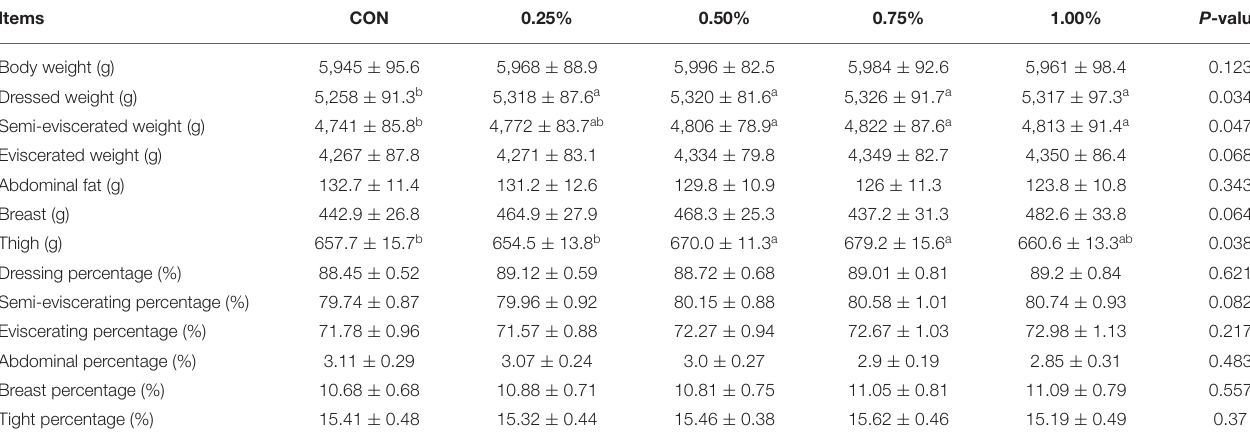
TABLE 3 | Effects of honeycomb flavonoids supplement on carcass performances (n =